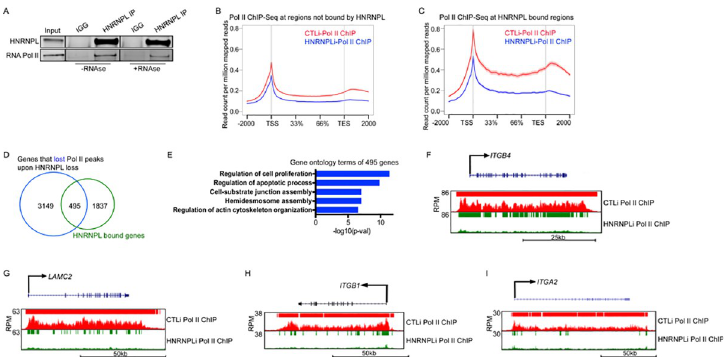
Fig 4. HNRNPL is required for Pol II–mediated transcription of integrin/ECM genes. (A) IPs were performed using an HNRNPL antibody or IGG and western blotted for HNRNPL or RNA Pol II protein expression. IPs were performed +/ − RNase A. A total of 1% of the cell lysate was used as input. Representative blots are shown. (B) RNA Pol II ChIP-Seq at regions not bound by HNRNPL in CTLi (red) and HNRNPLi (blue) cells. Y-axis is shown as read count per million reads, and X-axis is the distance along genes. TSS is transcription start site, and TES is transcription end site. Pol II ChIP-Seq in CTLi and HNRNPLi cells were performed in duplicates. (C) Pol II ChIP-Seq at regions bound by HNRNPL in CTLi (red) and HNRNPLi (blue) cells. (D) Overlap between HNRNPL bound genes (HNRNPL ChIP-Seq) and genes that lost Pol II peaks upon HNRNPL knockdown. (E) GO terms of the 495 genes that